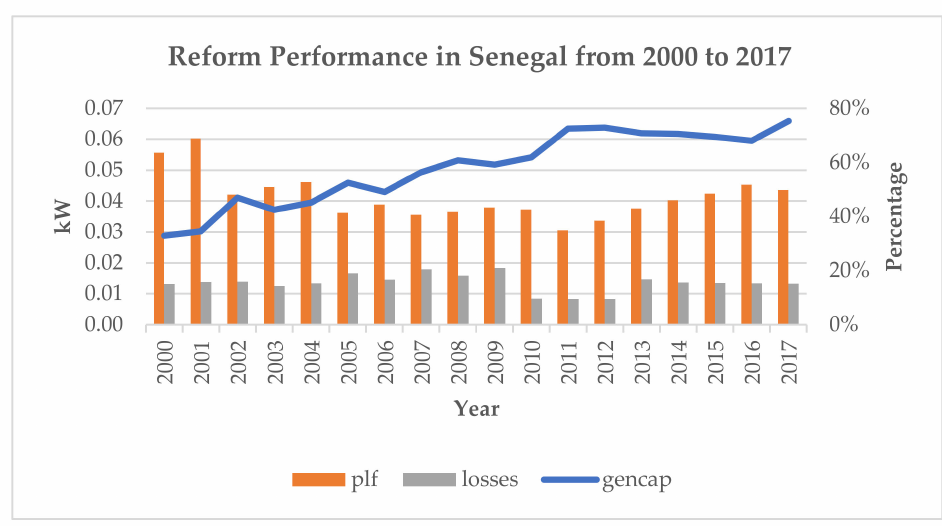
Figure 5. Evolution of plant load factor (in percentage), technical network losses (in percentage), and installed generation capacity per capita (in kilowatt) in